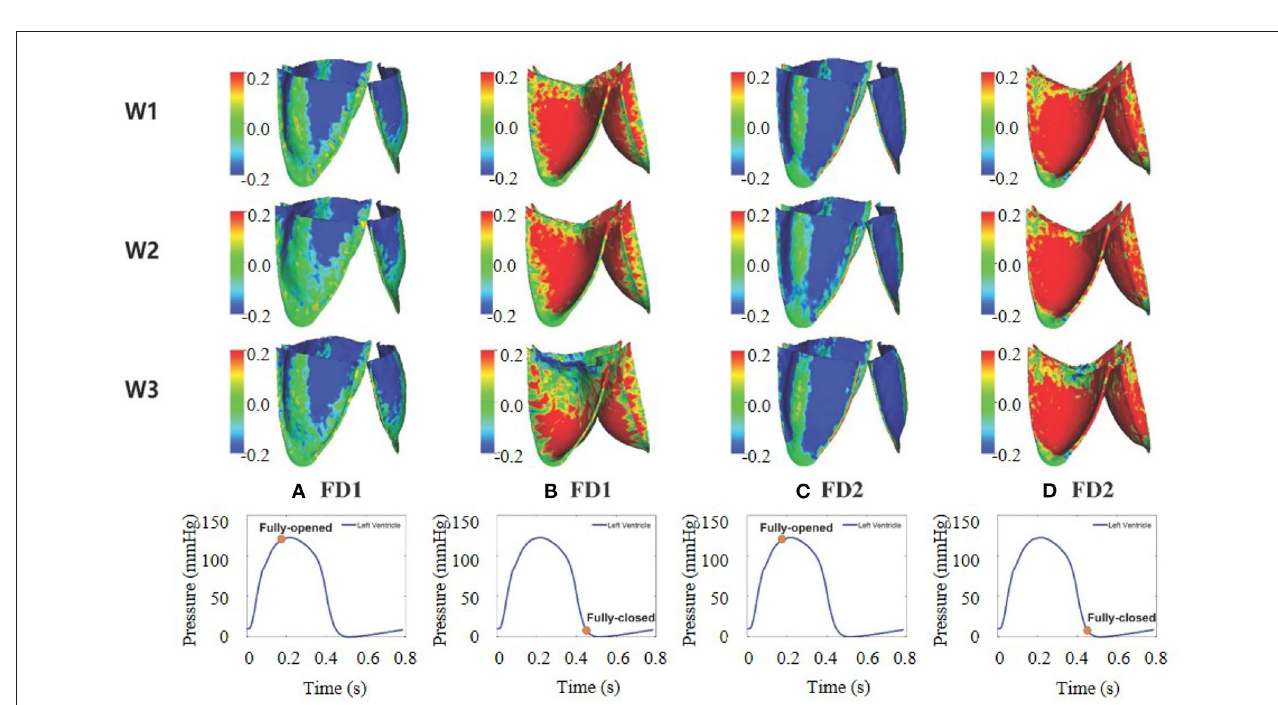
FIGURE 9 | Fiber strain distribution of aortic valve (AV) leaflets for the six different cases. (A–D) The first two columns correspond to FD1 under the fully opened and fully closed states, and the last two columns correspond to FD2 under the fully opened and fully closed states.